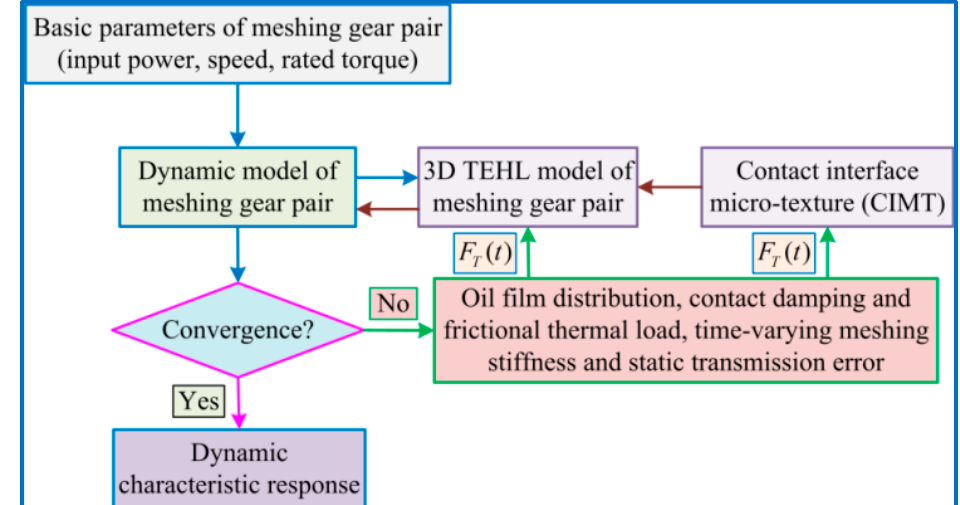
Figure 3. Flowchart of CIMT calculation method.